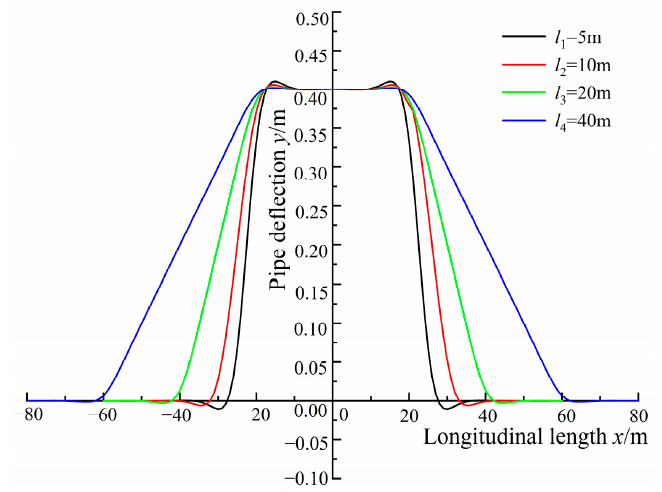
Figure 8. Deflection of pipe under different lengths of the transition region.